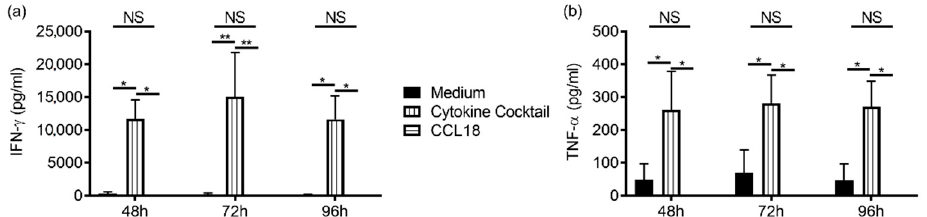
Figure 4. CCL18 does not induce IFN- γ nor TNF- α production by NK cells. Purified NK cells from nonallergic ( n = 6) donors were cultured in medium or stimulated for 48, 72, and 96 h with cytokine cocktail (IL-2+IL-12+IL-15) or CCL18. IFN- γ ( a ) and TNF- α ( b ) were measured in supernatants. * p < 0.05, ** p < 0.01, NS: not